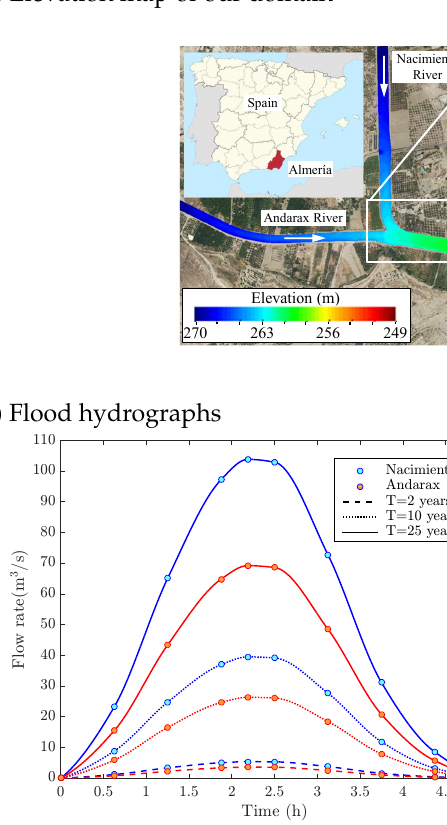
Figure 8. Model geometry and input flow-rates. In panel ( a ) we plot the location of the study area and the elevation map of our domain. Panel ( b ) includes the flood hydrographs for three return periods: T = 2, 10, and 25 years. Panel ( c ) depicts two flood hydrographs for the return period T = 10 years. The plot includes two discharge ratios, i.e., two flow distribution between the Nacimiento and Almarax rivers. The Nacimiento river is 40 km in length at the junction. The catchment area is 600 km 2 , the terrain elevation at the junction is about 263 m and the maximum elevation is about 1100 m. The Almarax